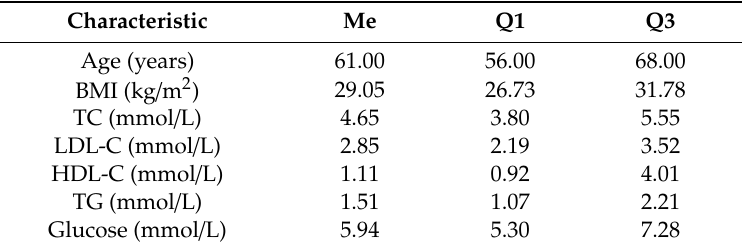
Table 1. Characteristics of study participants ( n =